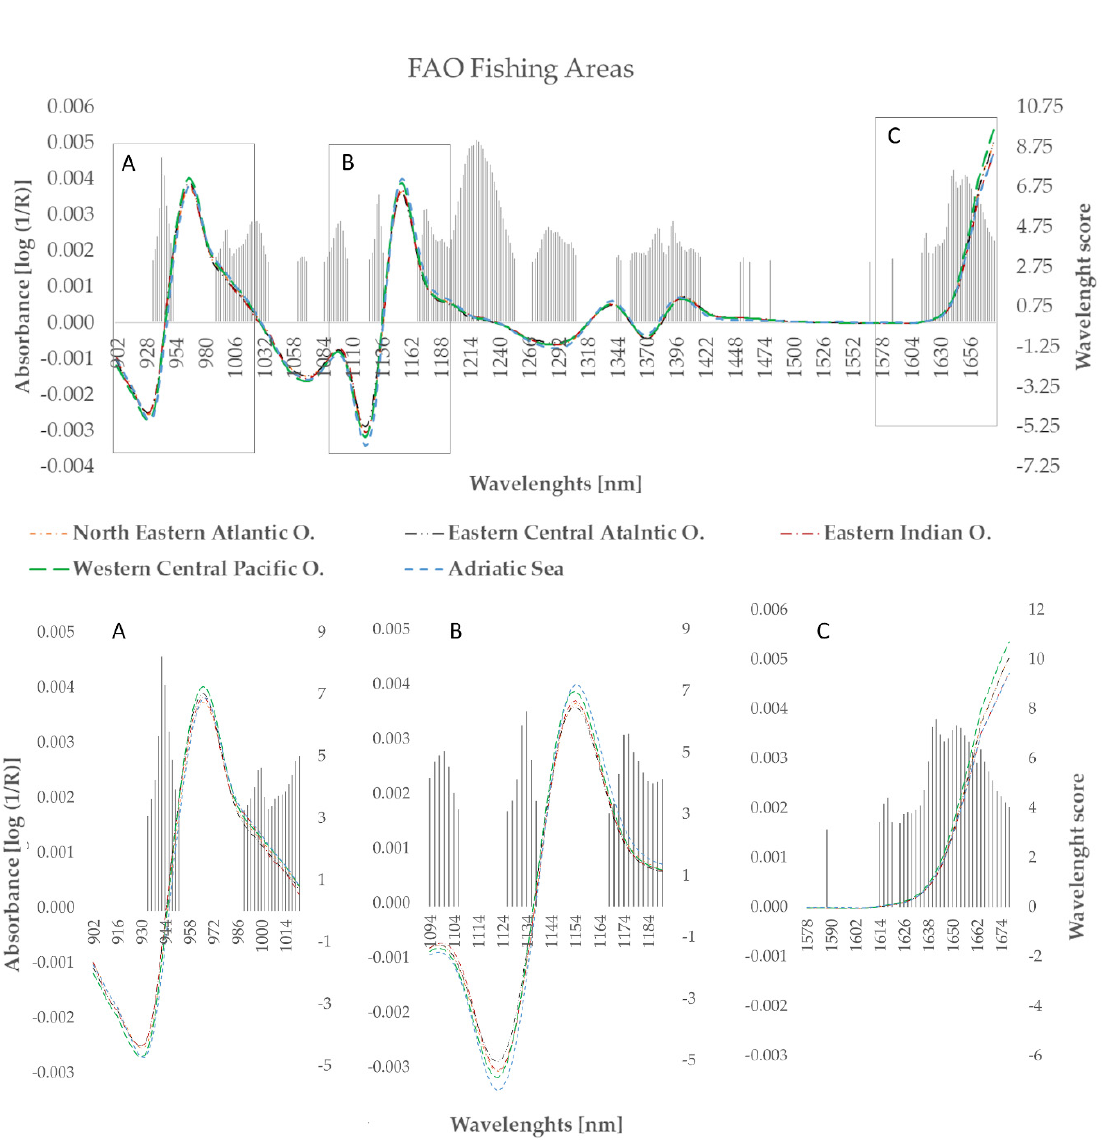
Figure 1. The mean NIR absorbance curves after standard normal variate, detrending, smoothing and the second derivative treatment and the most informative wavelengths selected by random forest (in grey) for predicting origin of FAO fishing area in cuttlefish. Magnification of spectra ranges where the differences in absorbance were detected ( A ) (902–1022 nm), ( B ) (1094–1190 nm), and ( C ) (1578–1678 nm).